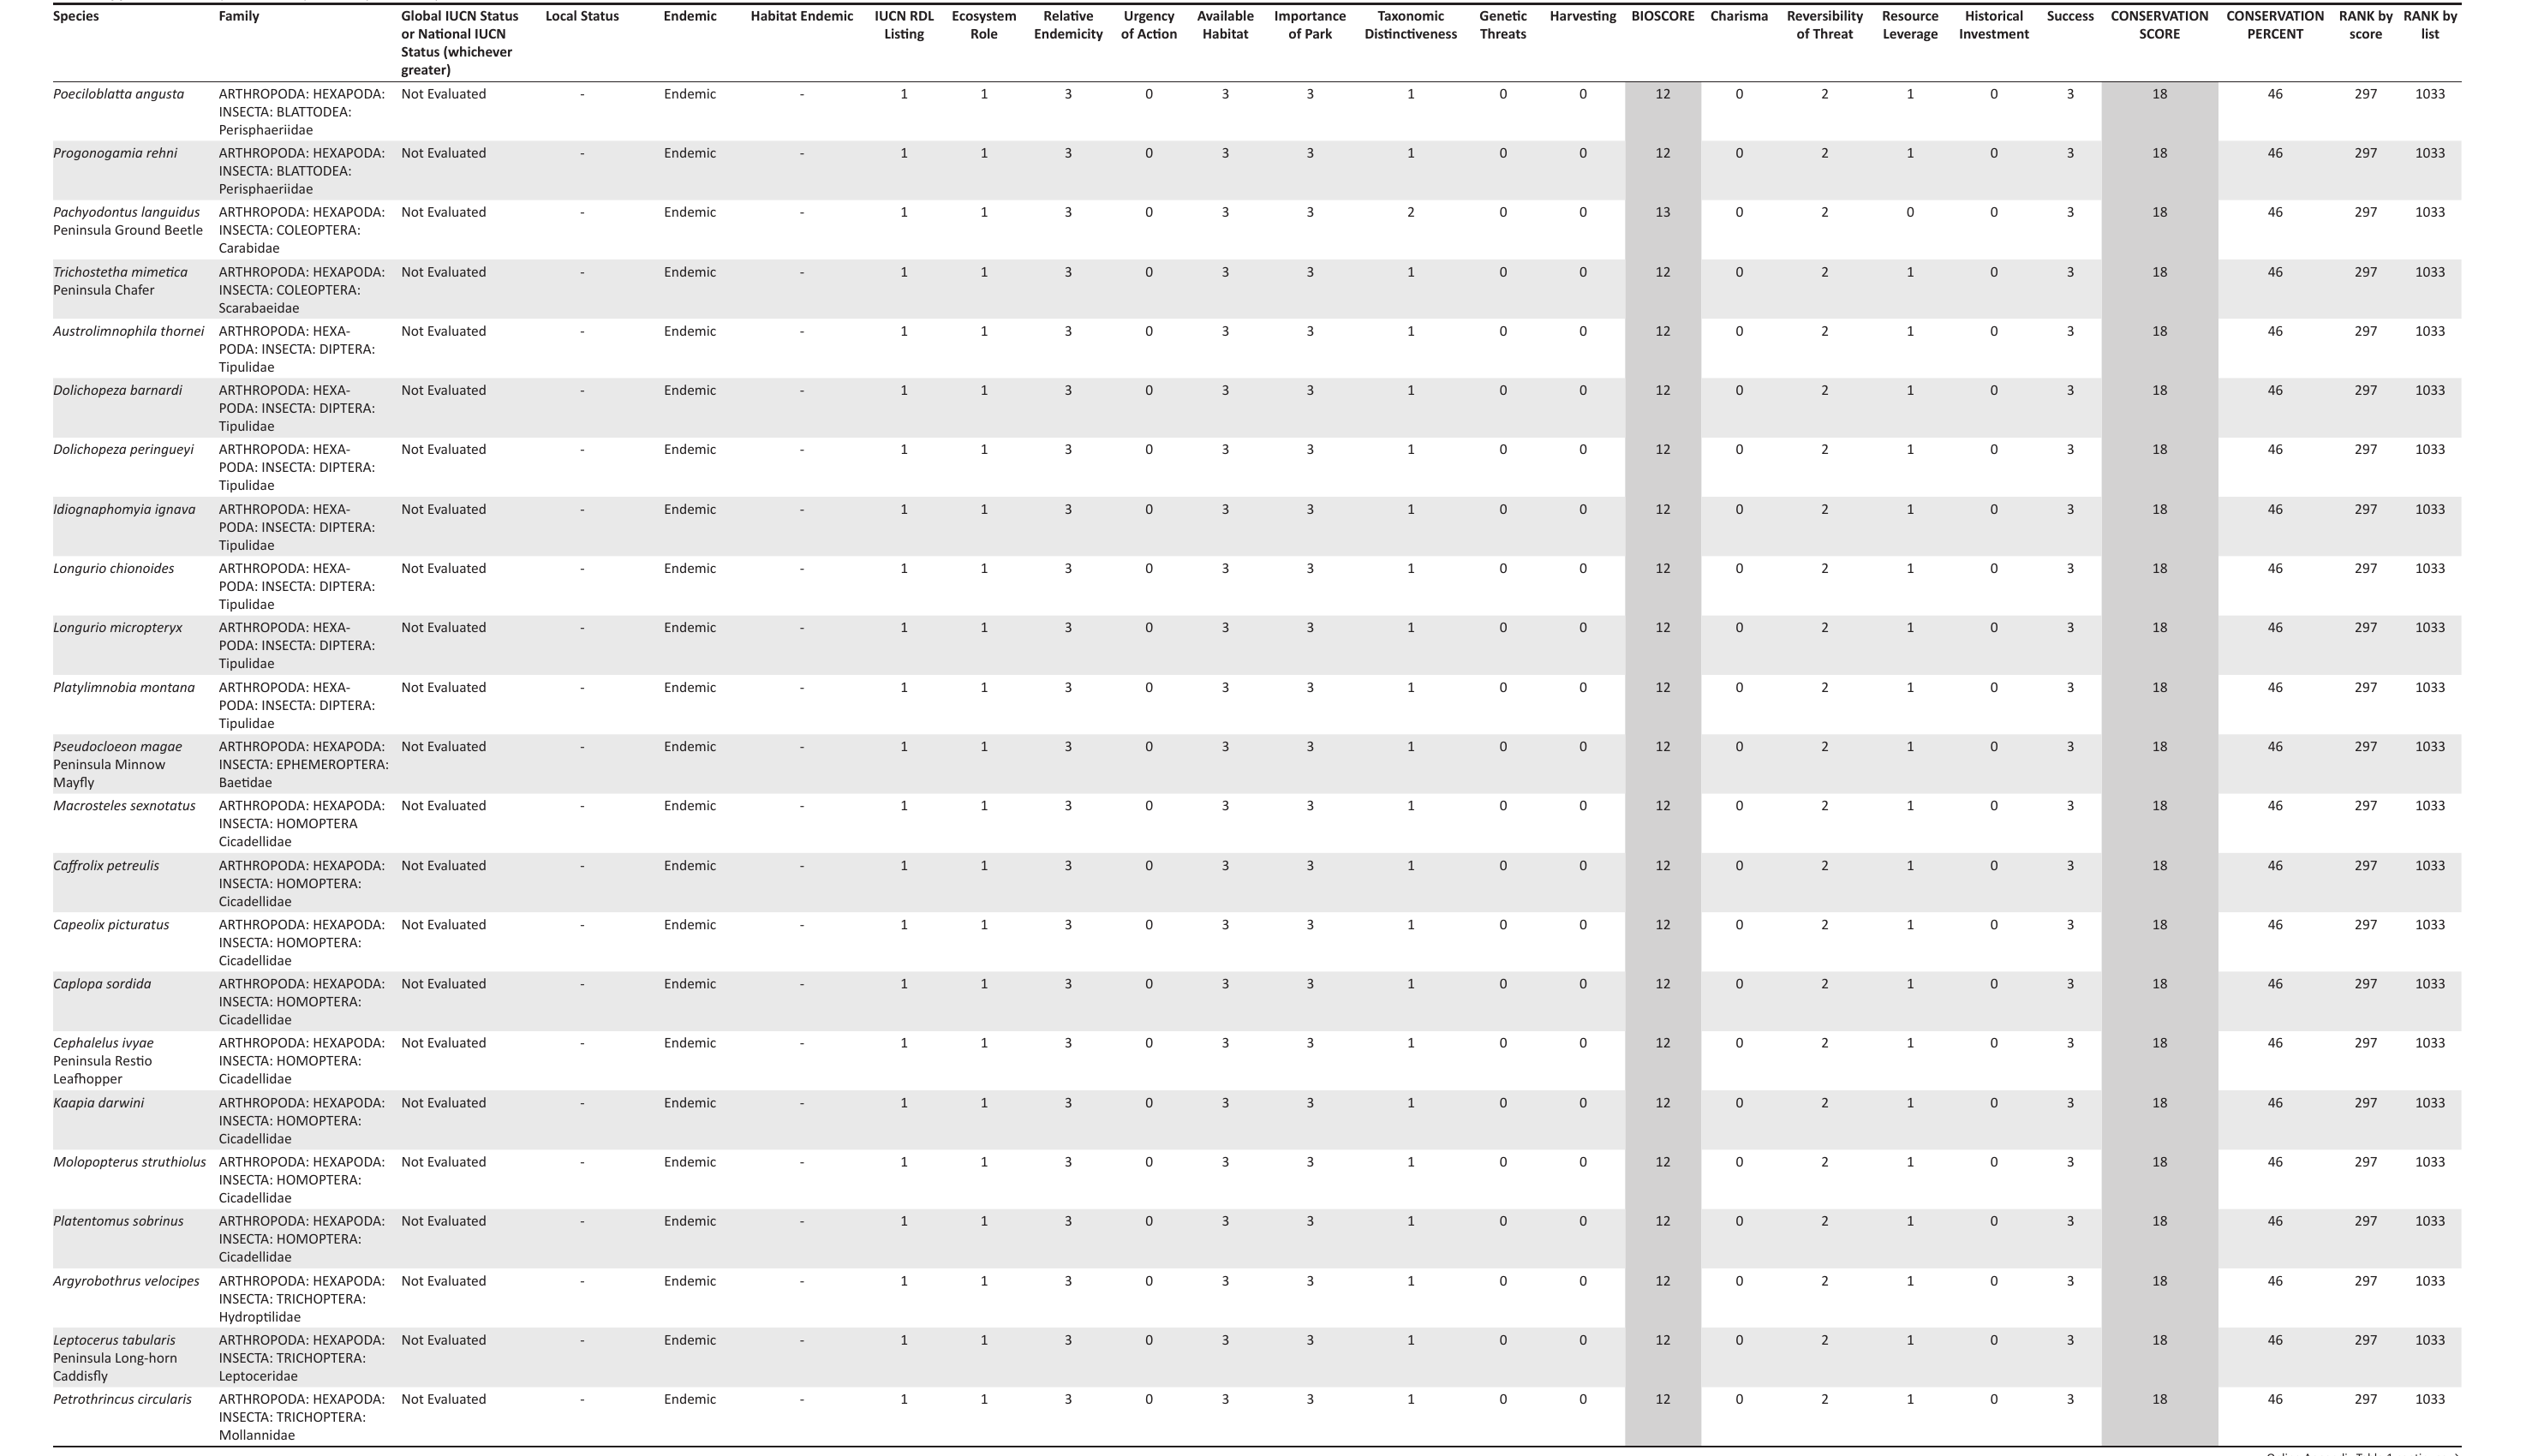
Online Appendix Table 1 (Continues...): List of species of Special Concern in the Table Mountain National Park and associated scores Species